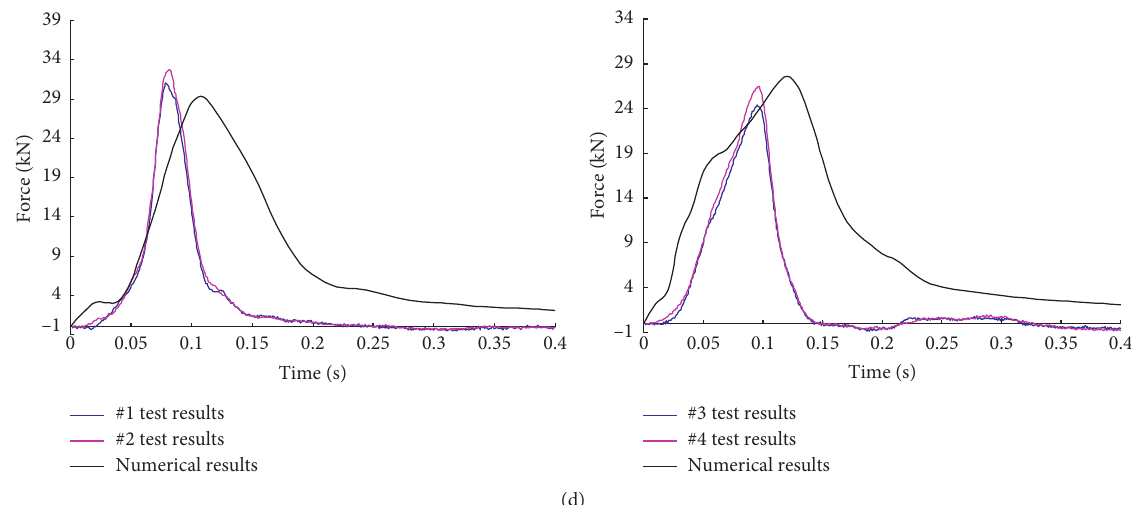
Figure 8: The contrast time history curves of the tension of the supporting rope. (a) Comparison between measurements under XT-2.5-20-2 conditions. (b) Comparison between measurement results under XT-2.5-20-3 working conditions. (c) Comparison between measurement results under XT-2.5-50-2 working conditions. (d) Comparison between measurement results under XT-2.5-50-3 working Table 4: The comparison table of the maximum instantaneous impact forces of the supporting ropes under different working conditions. First supporting rope (kN) Rock fall quality (kg) Test conditions